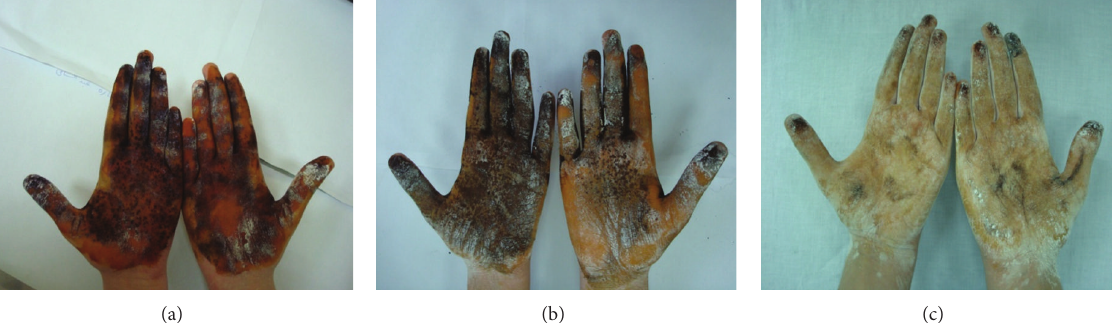
Figure 1: Right hand treated with Botox, left hand with Dysport showing Minor’s iodine starch test (a) before treatment, (b) 3 weeks posttreatment, and (c) 8 weeks